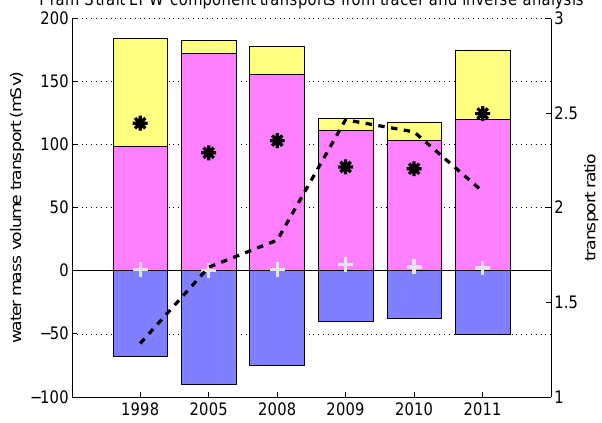
Fig. 5. Meridional section transports of LFW components in the Fram Strait between 10.6 ◦ W and 4 ◦ E for the years shown. The bars show the portion of every component: FPW (top, yellow), MW (magenta, middle) and FSIM (blue, bottom). The asterisks repre- sent the LFW transport, the crosses the transports of only positive fractions of FSIM and the line the ratio of MW to FIFB